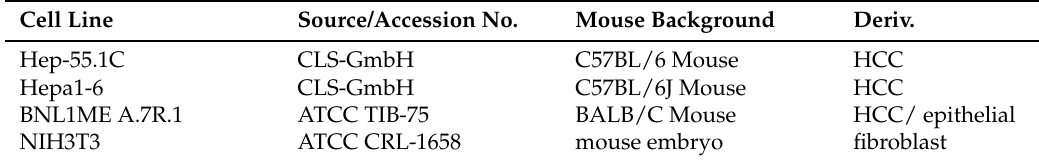
Table 2. Murine Cell lines used for